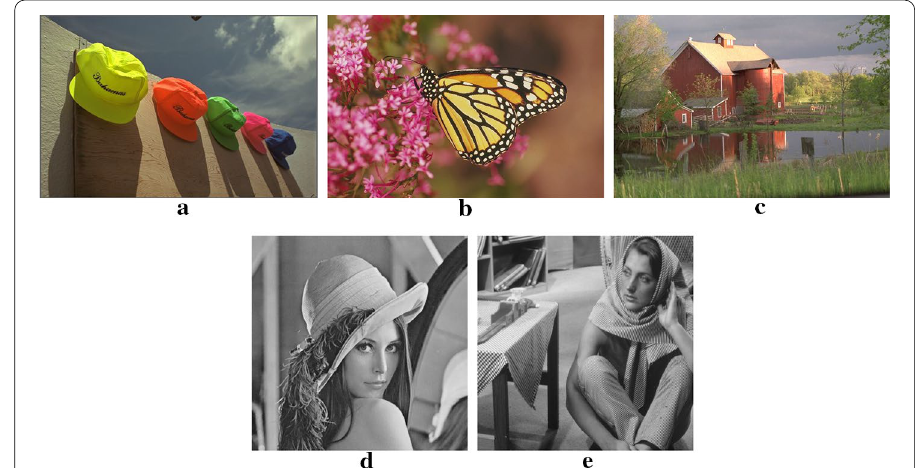
Fig. 9 Used images. The JPWL images used in the simulation part